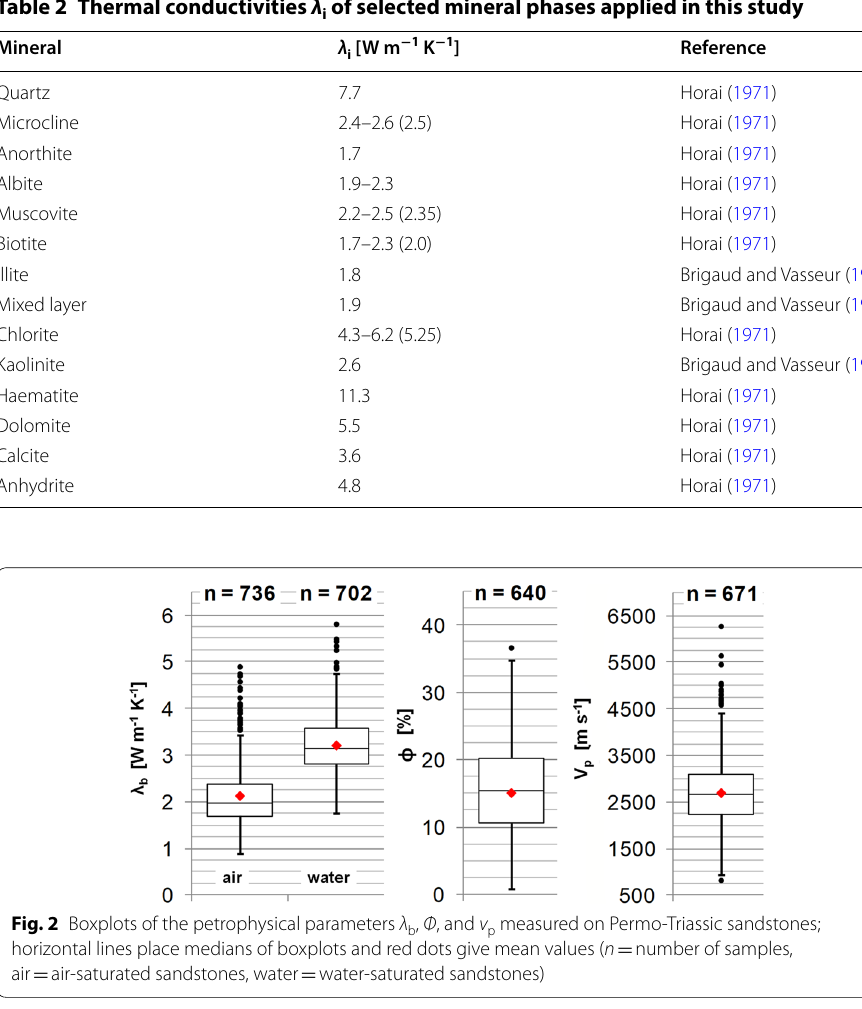
Table 2 Thermal conductivities λ